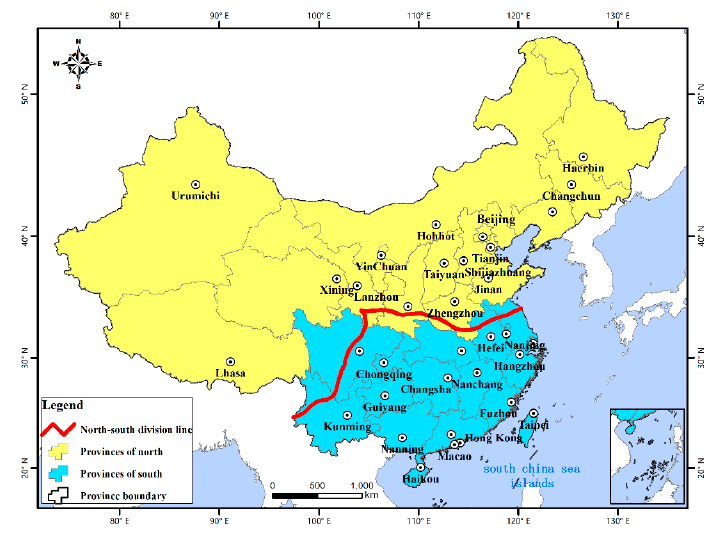
Figure 1. Study area including the North-South division line.